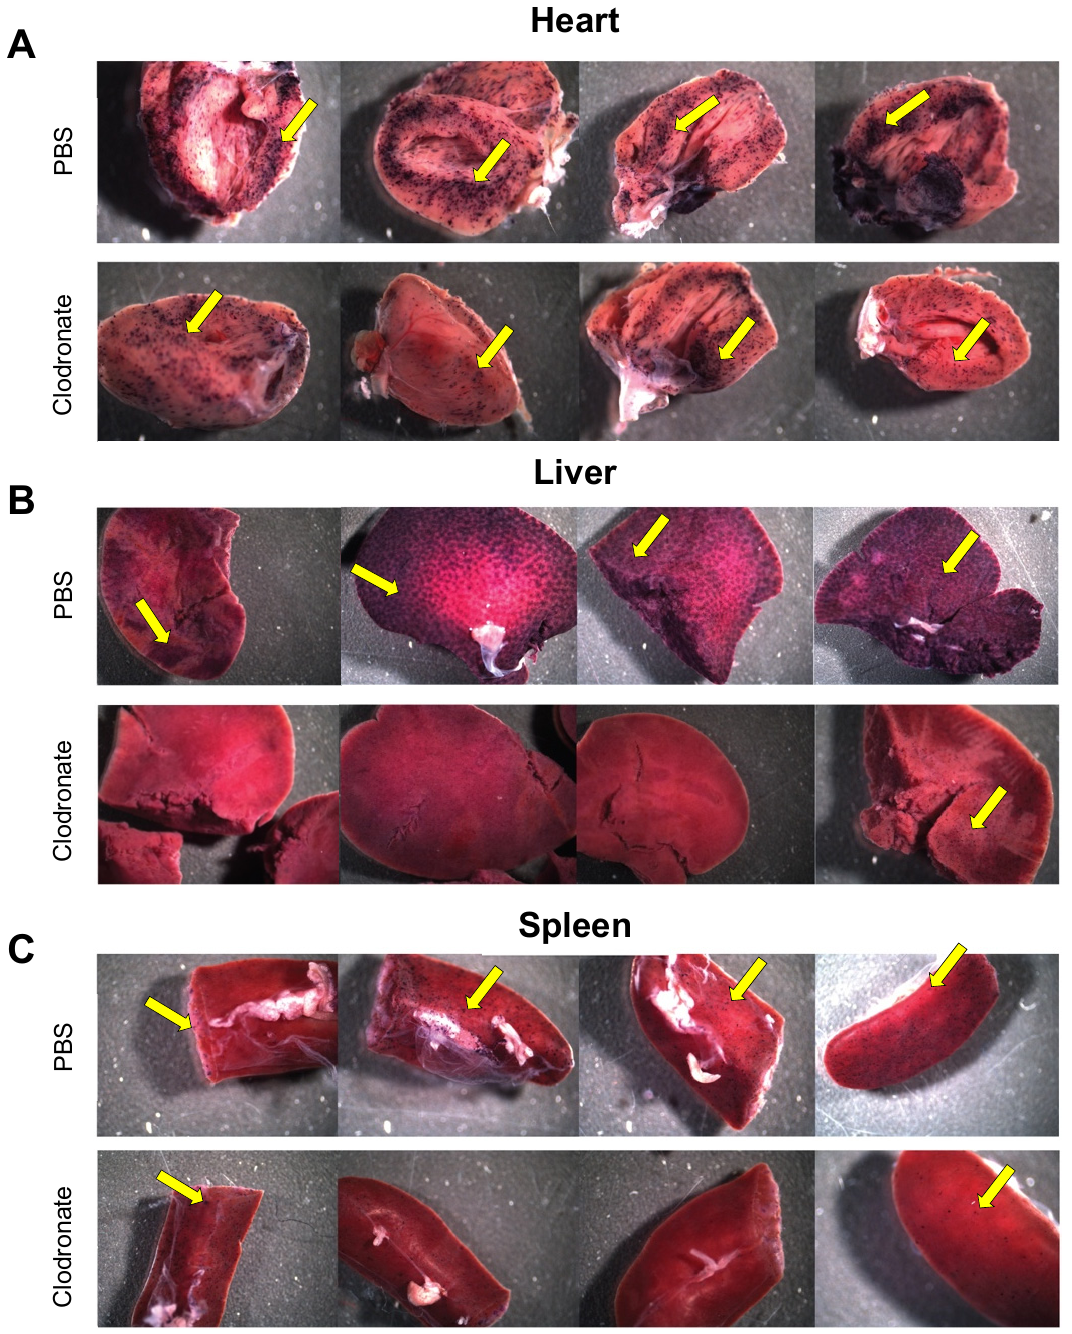
Figure 2. Gross comparison of mice ( n = 4) transduced systemically (via tail vein) with 1 × 10 11 vg of AAV6 vector expressing human placental alkaline phosphatase (hPLAP) after being given an intravenous injection of clodronate liposomes or PBS, 48 h prior. Mice were euthanized 28 days post-AAV administration and tissues fixed and stained for hPLAP expression. There appeared to be a trend towards more expression in clodronate-untreated mice, particularly in the heart ( A ) and liver ( B ), but less so in the spleen ( C ). Images pictured are from individual mice. Yellow arrows point to regions of purple punctate staining representative of hPLAP expression.